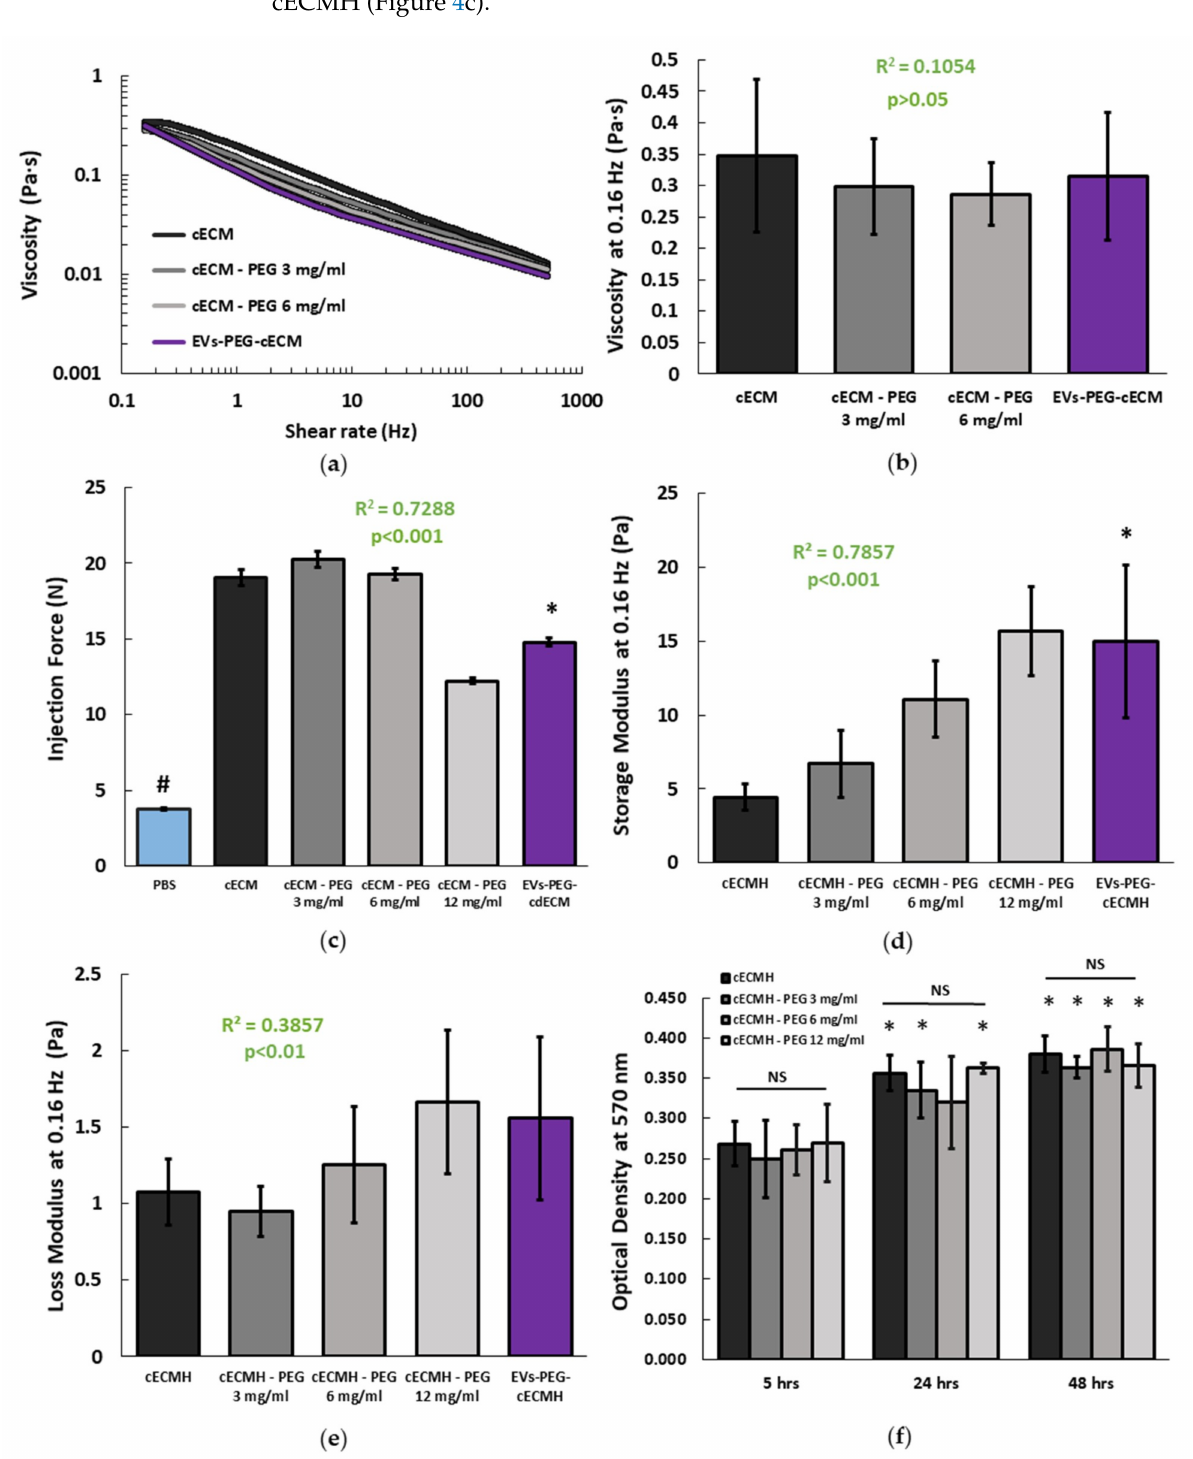
Figure 3. Mechanical properties and degradation of the cECMH alone, with PEG, and with PEG-isolated EVs. ( a ) Average viscosity of the different hydrogel solution formulations ( n = 3 for each condition, each in triplicate). ( b ) Viscosity at 0.16 Hz ( n = 3). Squared Pearson’s correlation coefficient for PEG concentration in the cECMH vs. viscosity at 0.16 Hz and its significance ( p > 0.05). ( c ) Force required for injection ( n = 3). Squared Pearson’s correlation coefficient for PEG concentration in the cECMH vs. injection force and its significance ( p < 0.001). * p < 0.001 vs. cECMH. # p < 0.001 vs. all other groups. ( d ) Storage modulus at 0.16 Hz ( n = 4). Squared Pearson’s correlation coefficient for PEG concentration